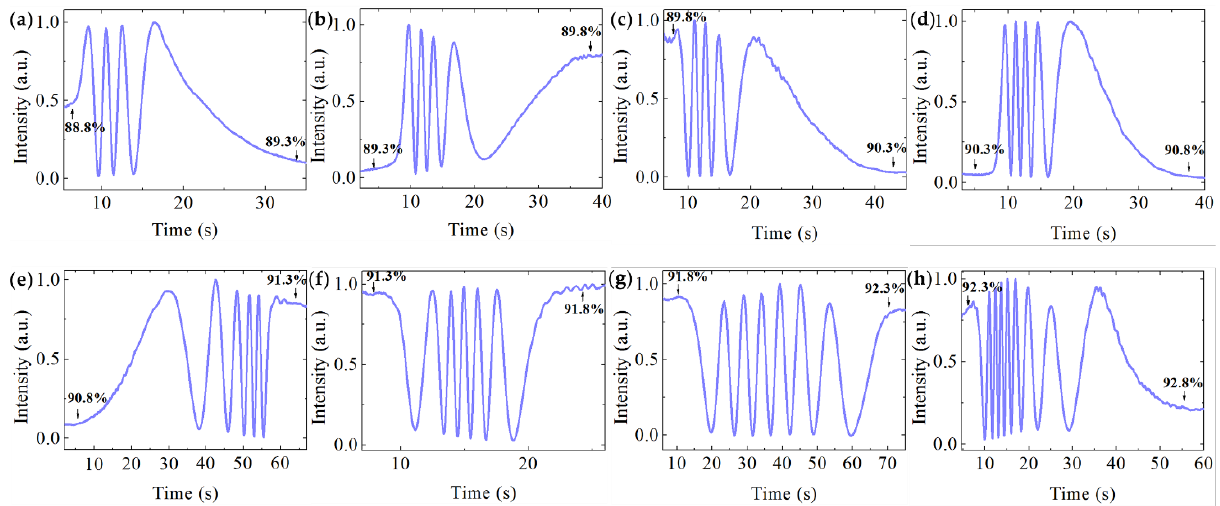
Figure 6. Interferograms of the MZI sensor measuring different volume percentage DMSO/water solutions. ( a ) 88.8% → 89.3%, ( b ) 89.3% → 89.8%, ( c ) 89.8% → 90.3%, ( d ) 90.3% → 90.8%, ( e ) 90.8% → 91.3%, ( f ) 91.3% → 91.8%, ( g ) 91.8% → 92.3%, ( h ) 92.3% → 92.8%.